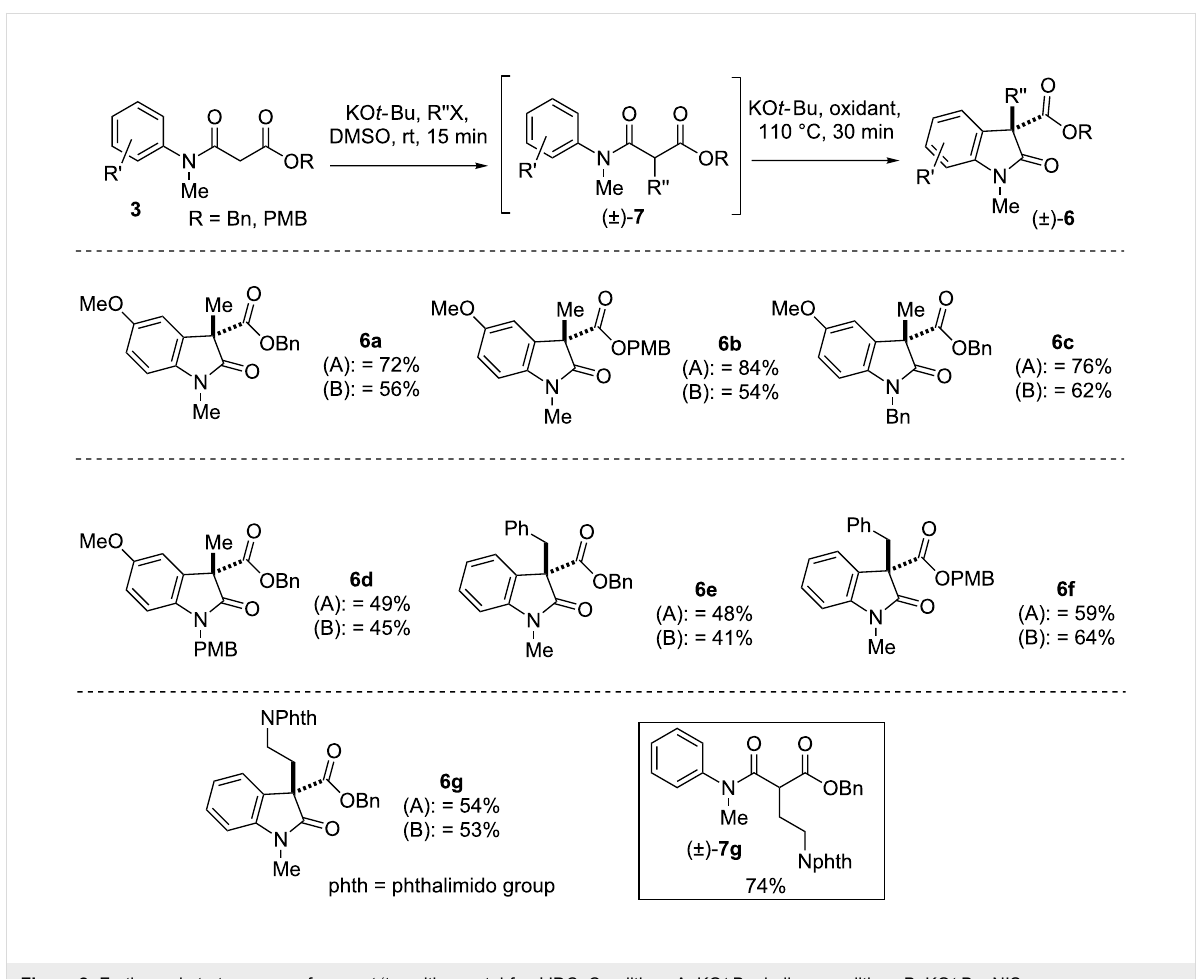
Figure 2: Further substrates scope of one-pot ‘transition metal-free’ IDC. Conditions A: KO t- Bu, iodine; conditions B: KO t -Bu,